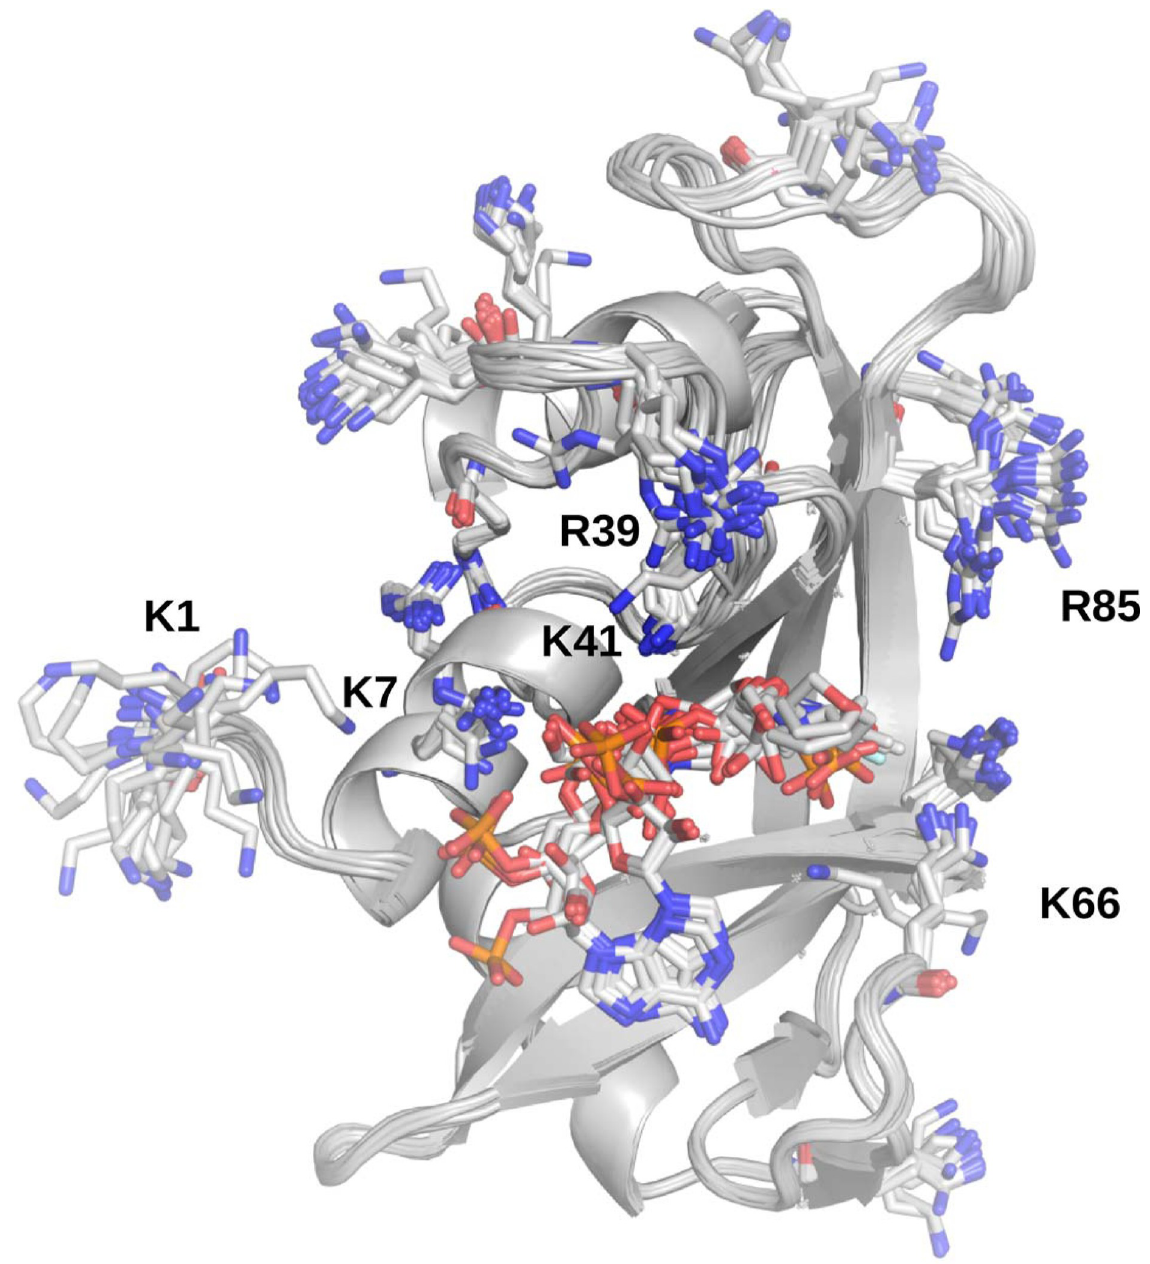
Fig 2. The 22 starting protein–ligand crystal and NMR structures aligned by C α . The protein backbone is in cartoon representation, colored in gray. Lysines, arginines, and ligands are given in stick representation with carbon atoms in white, nitrogens in blue, oxygens in red, and phosphorus in orange. The view is centered on the ligands in the binding groove of the enzyme. Also labeled are several lysine and arginine residues, which are further discussed in the